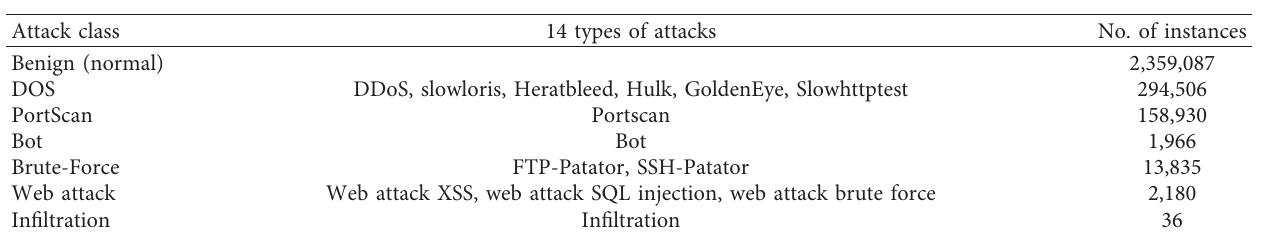
Table 9: CICIDS dataset.